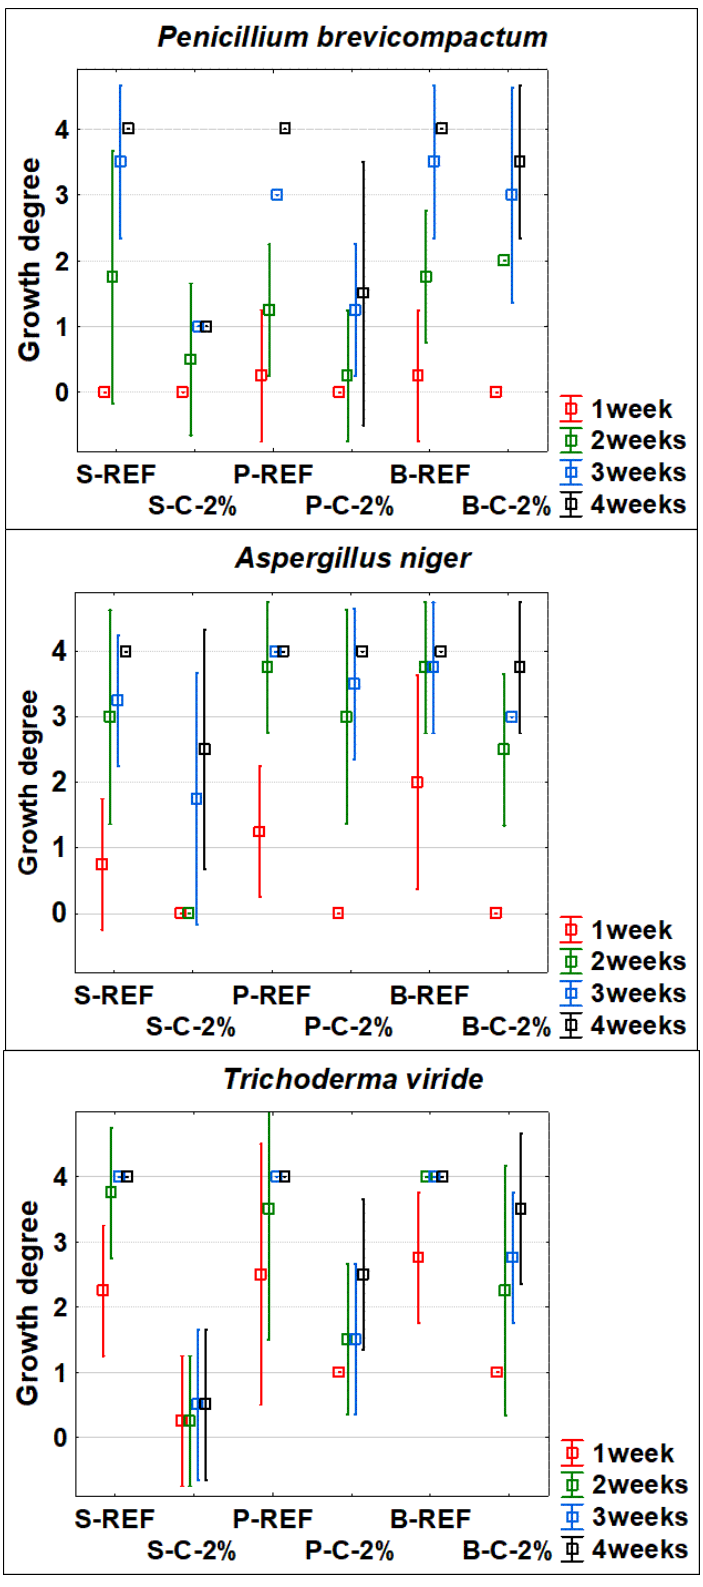
Figure 2. Mould growth.